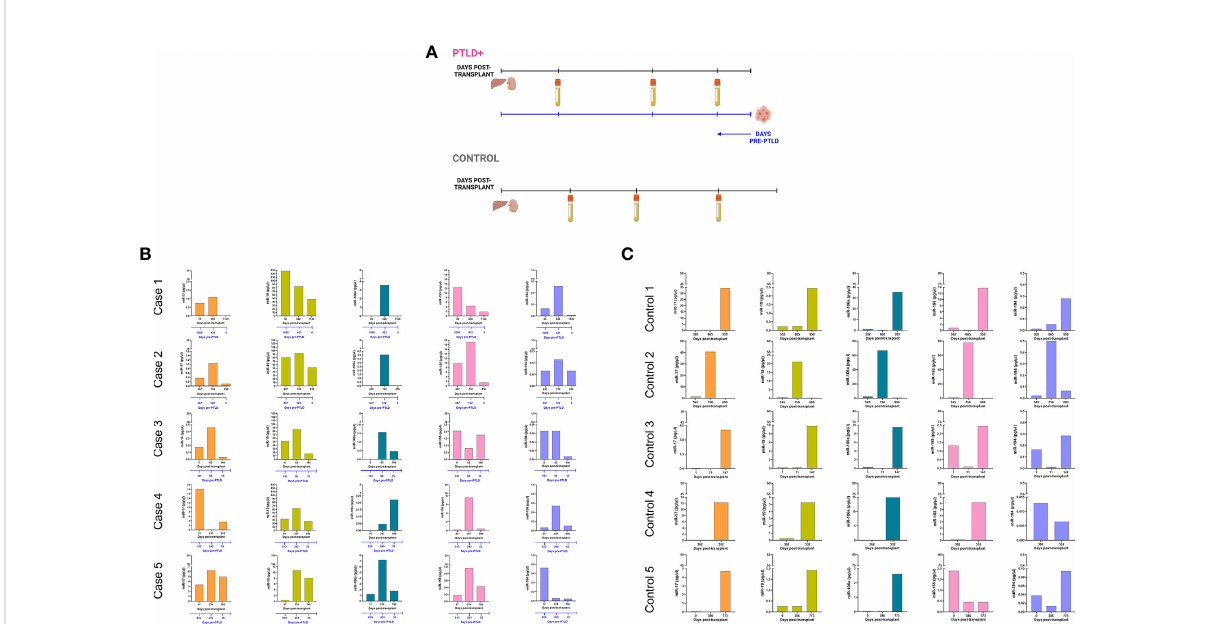
FIGURE 2 Longitudinal analysis demonstrates a decrease in miR levels prior to a diagnosis of PTLD. (A) Schematic diagram of the pairing of PTLD+ (n = 13) and control (n = 13) subjects by matching organ and time of sample collection post-transplant. In both PTLD and control groups, the timeline in black represents the number of days post-transplant. In the PTLD group, the timeline in blue represents the number of days prior to PTLD diagnosis, indicated by Day 0. In the PTLD+ group, the last samples were collected between 0-60 days prior to PTLD diagnosis. (B) Concentrations of miR-17, miR-19, miR- 106a, miR-155 and miR-194 were measured by qPCR in plasma samples collected at three timepoints post-transplant with the last sample collected within 0-60 days prior to PTLD diagnosis (n = 5). (C) Concentrations of miR-17, miR-19, miR-106a, miR-155 and miR-194 were measured by qPCR in plasma samples collected post-transplant from control patients (n = 5) at timepoints matched with paired PTLD+ subjects.